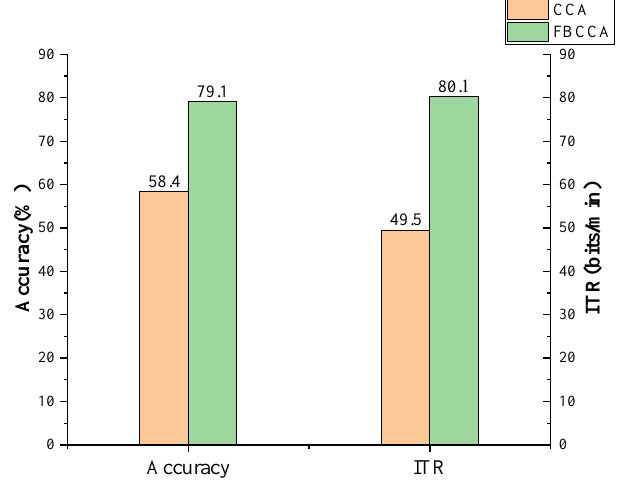
Figure 9. The accuracy and ITR of FBCCA and